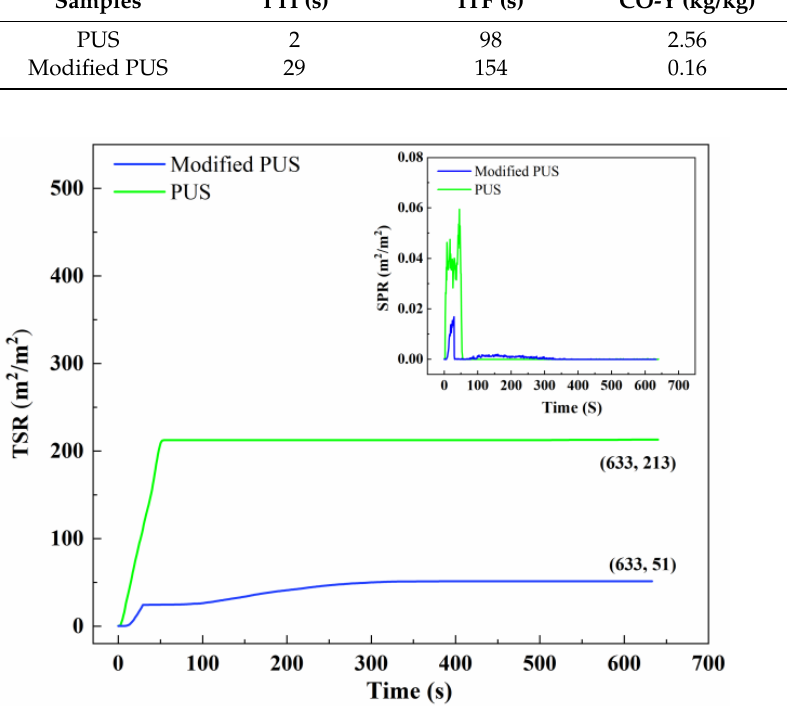
Figure 3. The total smoke release (TSR) and the smoke produce rate (SPR) curves of PUS before and after